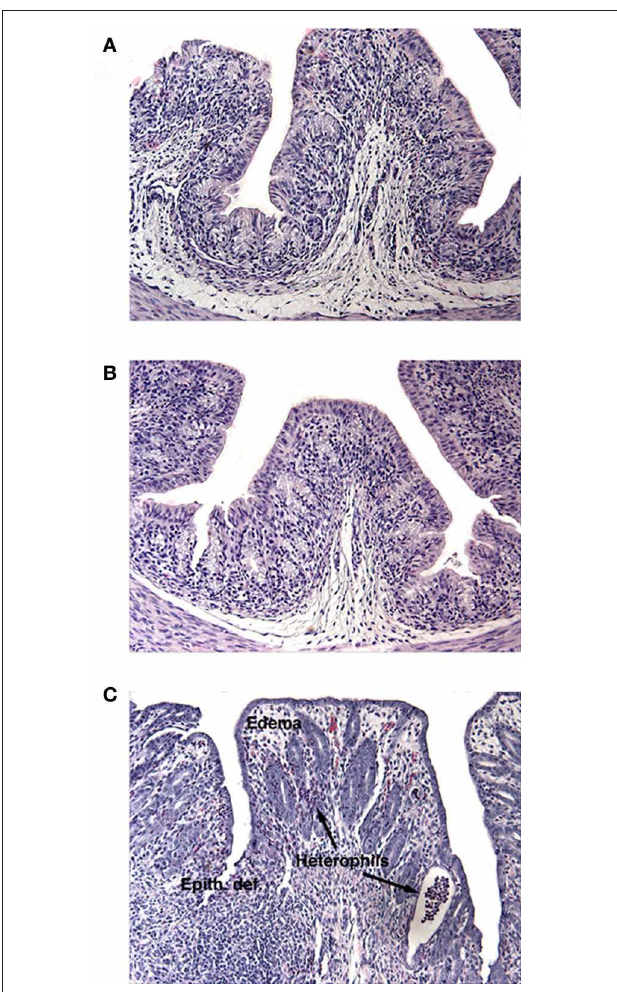
FIGURE 1 | H and E stained sections of infant rabbit colon following treatment with (A) HI, (B) Mut, or (C) Stx2. Tissue from Stx2-treated rabbits show increased edema, epithelial defects (Epith def), and heterophil infiltration.